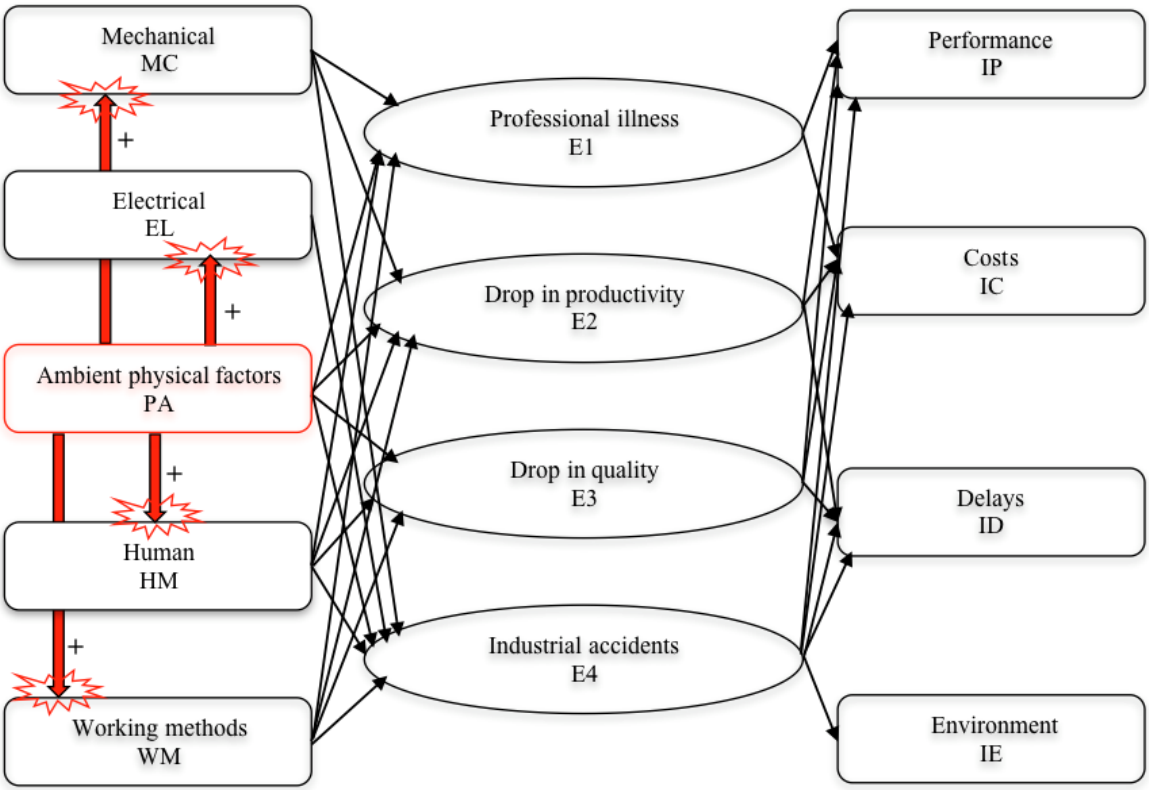
Figure 9. Causal links between the elements of risk and reinforcing effects of ambient physical factors. [+: reinforcing effect].